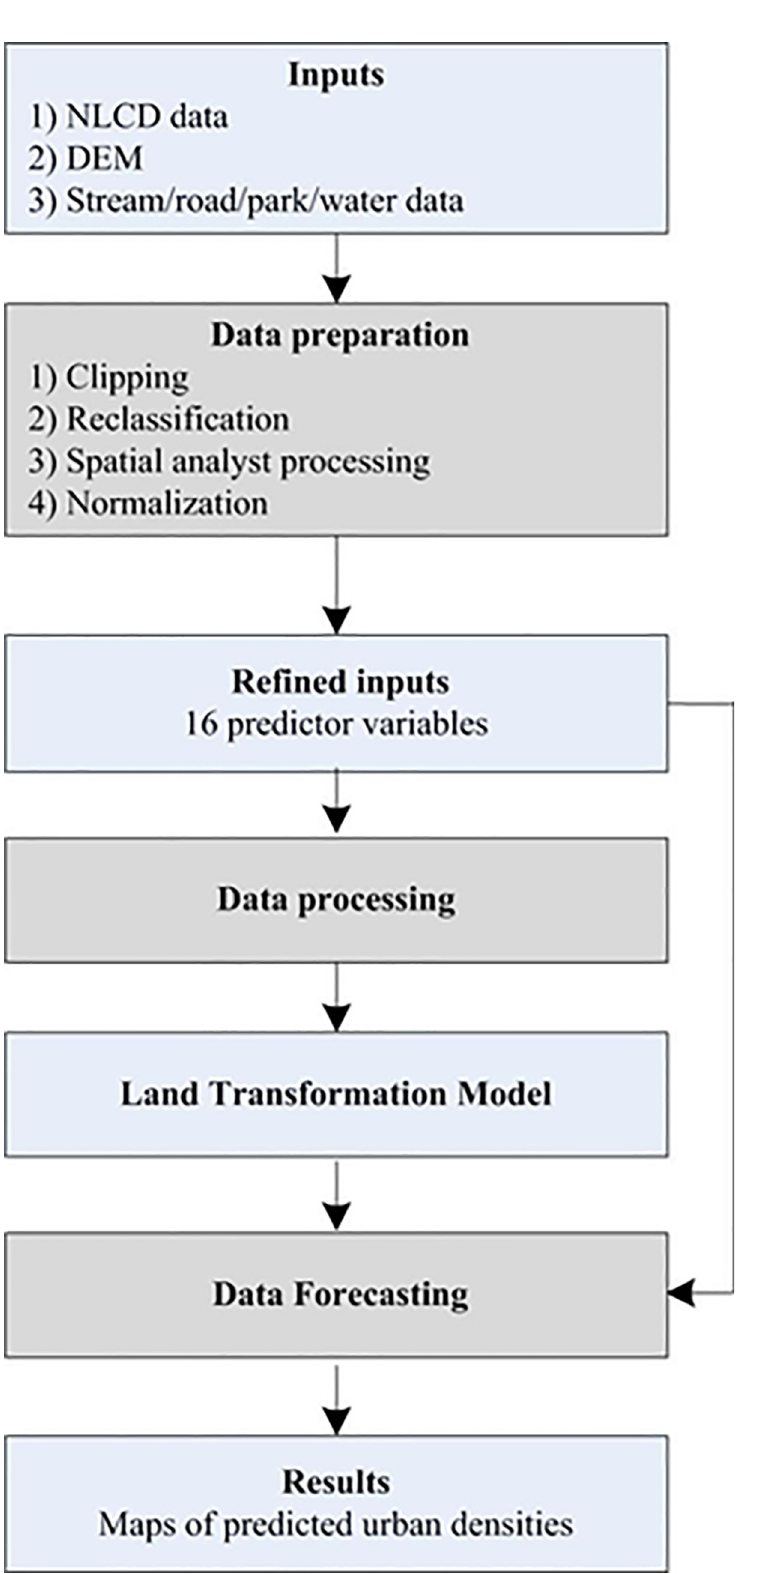
Fig 2. Modeling steps of the